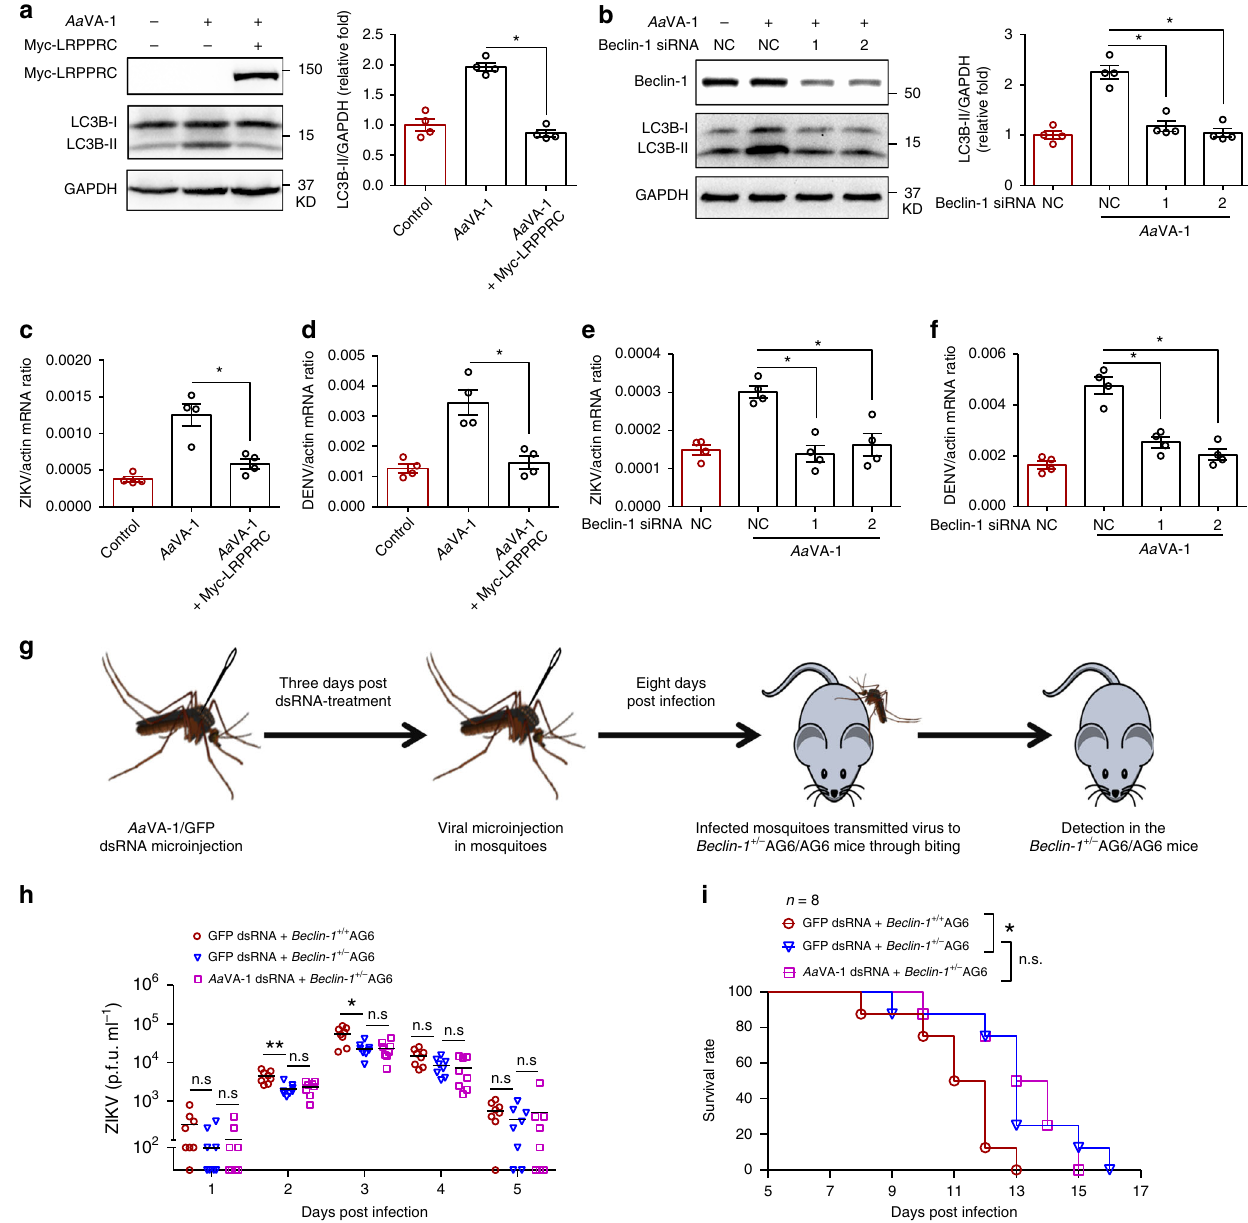
Fig. 6 Aa VA-1-mediated Beclin-1 signaling activation facilitates viral transmission. a , b Ectopic expression of LRPPRC or siRNA-mediated knockdown of Beclin-1 impaired the Aa VA-1-mediated autophagy activation in human THP-1 cells. a Puri fi ed Aa VA-1 (1 μ g/ml) was incubated with either LRPPRC- expressing or mock cells for 6 h. b Puri fi ed Aa VA-1 (1 μ g/ml) was incubated with either Beclin-1 -silenced or mock cells for 6 h. Autophagy activity was detected by western blotting with anti-LC3B antibody (left panel), and quanti fi cation of the signaling intensity of LC3B-II relative to GAPDH (right panel). n = 4 independent experiments. c – f Either ectopic expression of LRPPRC ( c , d ) or siRNA-mediated knockdown of Beclin-1 ( e , f ) restored the enhancement of DENV and ZIKV infectivity caused by Aa VA-1. Puri fi ed Aa VA-1 (1 μ g/ml) was incubated with the cells. The same amount of BSA served as a negative control. The MOI for infection was 0.1 for DENV and ZIKV. Gene quantities were normalized against human actin (NM_001101.4). n = 4 independent samples. The experiments were repeated 3 times with the similar results. g – i A de fi ciency of Beclin-1 in the host offsets Aa VA-1-mediated ZIKV transmission by A. aegypti . g Schematic representation of the study design. The AaVA-1 gene was silenced by dsRNA thoracic microinjection in A. aegypti . Mosquitoes inoculated with GFP dsRNA served as mocks. Three days post gene silencing, the dsRNA-treated mosquitoes were thoracically infected with ZIKV. After an additional 8 days of rearing, either Beclin-1 + / − AG6 or the Beclin-1 + / + AG6 mouse were subjected to a blood meal by the infected mosquitoes. Both ZIKV viremia and mortality were recorded daily after mosquito biting. h The ZIKV load in mouse plasma was detected by a plaque assay. i Animal mortality was recorded daily ( n = 8 mice per group). The data were combined based on two independent experiments. a – f, h The data are presented as the mean ± SEM. A nonparametric Mann – Whitney test was used for the statistical analysis. * p < 0.05, ** p < 0.01, n.s., not signi fi cant ( p ≥ 0.05). i Survival rates of the infected mice were statistically analysed using the log-rank (Mantel – Cox) test. Source data are provided as a Source Data fi